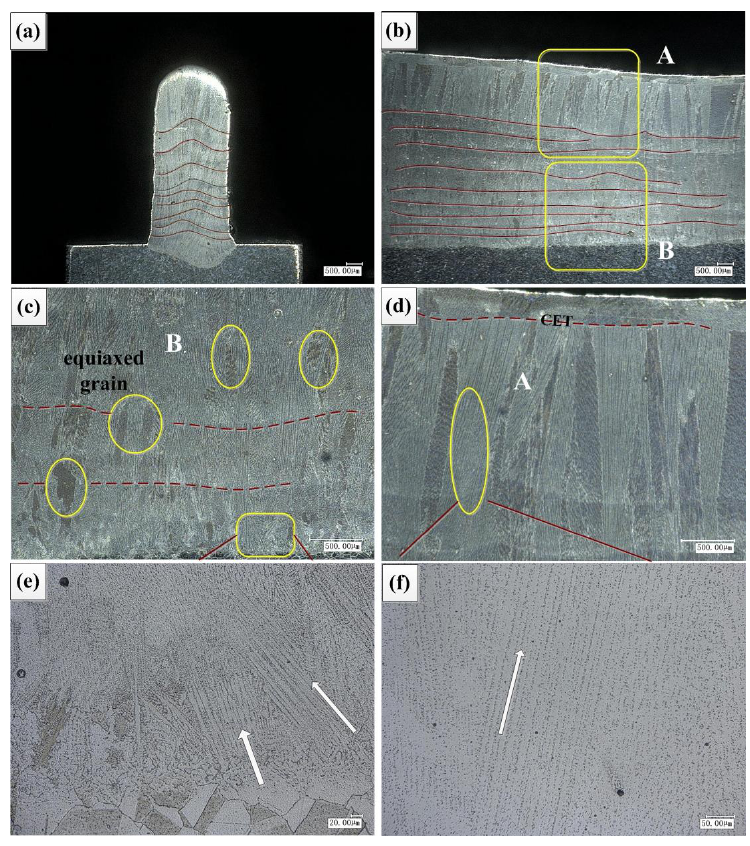
Figure 17. Longitudinal section morphology of cladding layer: ( a ) morphology of cross section, ( b ) longitudinal section morphology, ( c ) B-bottom of longitudinal section, ( d ) A-top of longitudinal section, ( e ) enlargement of bottom, ( f ) enlargement of top.